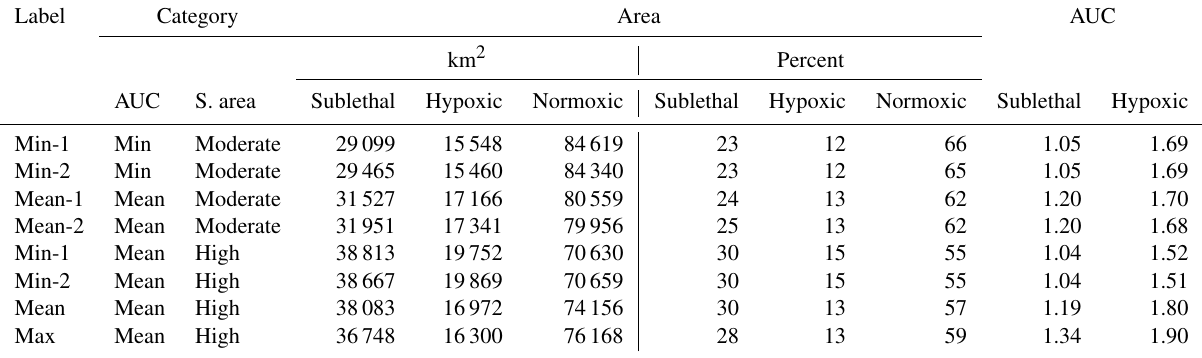
Table 1. Areas (hypoxic, sublethal, and normoxic; km 2 and percent of grid) and AUC (area under the curve) values for eight snapshots selected from the hourly DO maps generated by FVCOM-WASP simulation of 10d (20–30 August 2002). Sublethal DO was defined as 2–4mgL − 1 . Based on the sublethal area and AUC values, each snapshot was labeled by category of total sublethal area (S. area; high or moderate) and by category of AUC (minimum, mean, or